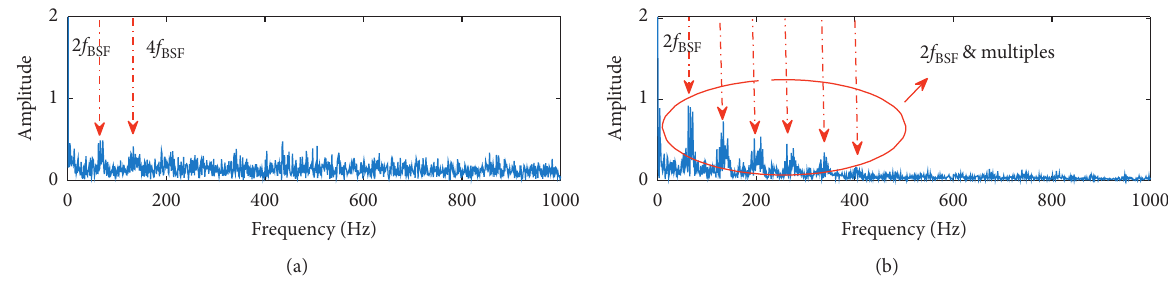
Figure 25: (a) Envelope spectrum of original bearing roller fault signal. (b) Envelope spectrum of signal in Figure